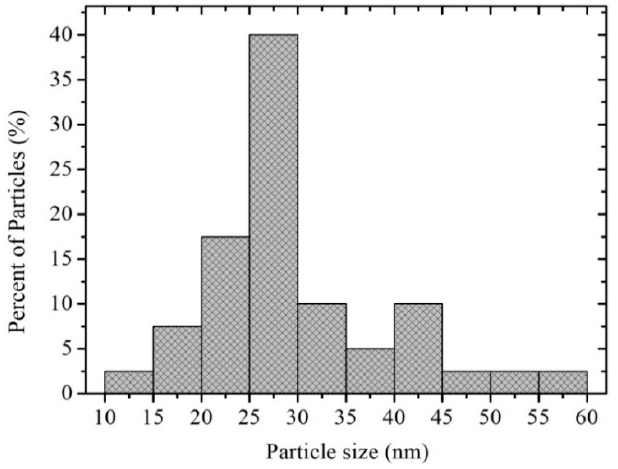
Figure 6. Histogram showing the nanoparticle size distribution of calcined MnSb 2 O 6 at 800 °C.